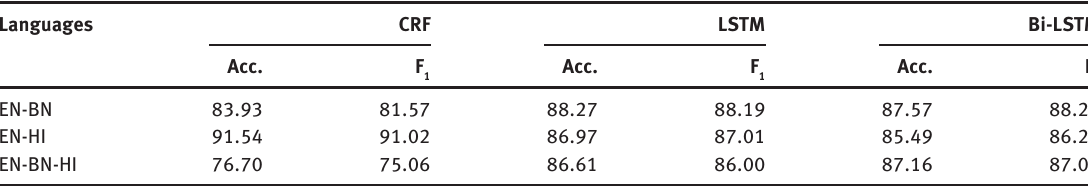
Table 2: System Performance (Accuracy and F